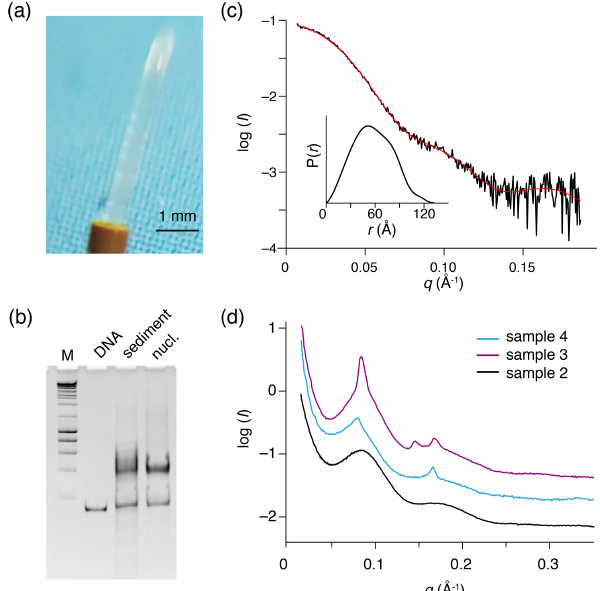
Figure 3. Recovered nucleosome sediment and SAXS scattering curves. (a) The nucleosome sediment of sample 2 (H2A-labeled nucleosomes) recovered from the ssNMR rotor after 34d of MAS and 11 months of storage at 4 ◦ C appears as a transparent semi- solid, paste-like gel. (b) Native PAGE analysis of the recovered sed- iment (sample 4, H3-labeled nucleosomes, lane 3) together with free 167bp DNA (lane 2) and a fresh reconstituted nucleosome (lane 3). DNA base-pair marker in lane 1. Positions of free DNA and nucleosomes are indicated. Presence of a pronounced nucleosome band with little free DNA indicates the recovered sediment con- sists of nucleosomes. (c) SAXS-based scattering curve of nucleo- somes in solution (6µmol/dm 3 , 1.3mg/cm 3 ) in PK10 buffer. The buffer-subtracted scattering profile (black) was fitted in GNOM as a monodisperse particle function (red). Inset shows the derived pair distance distribution function. (d) SAXS-based scattering curves of the recovered nucleosome sediments, color coding indicated. All three samples feature a distinctive peak at q ∗ ∼ 0 . 08, corresponding ). The scattering curve to a characteristic distance of 7.8nm ( d = 2 π q of sample 3 (H2A-labeled nucleosome with co-sedimented LANA) features few relatively sharp peaks, indicative of more long-range ordering. Notably, this sample was the least